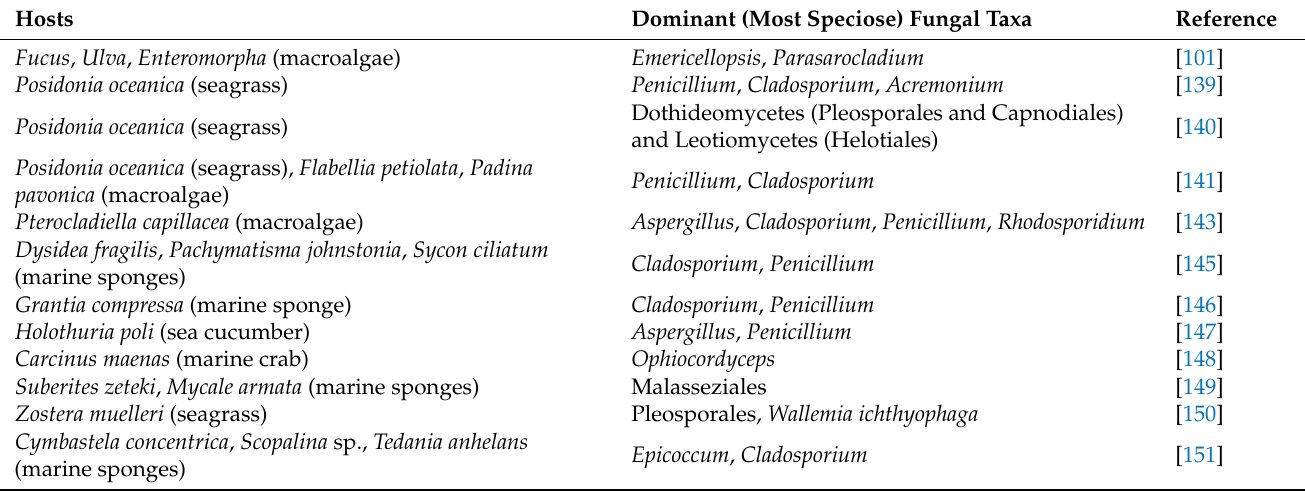
Table 4. Endophytes/endozoans isolated from different substrates in marine